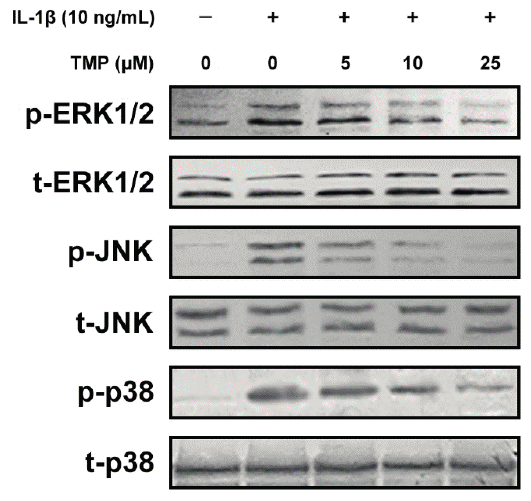
Figure 7. Effect of tetramethylpyrazine (TMP) on IL-1 β -induced phosphorylation of MAPKs in TR-iBRB2 cells. With the treatment of indicated drugs, the phosphorylation of ERK1/2, JNK and p38 MAPK was determined by Western blot analysis. All data were representative of three independent